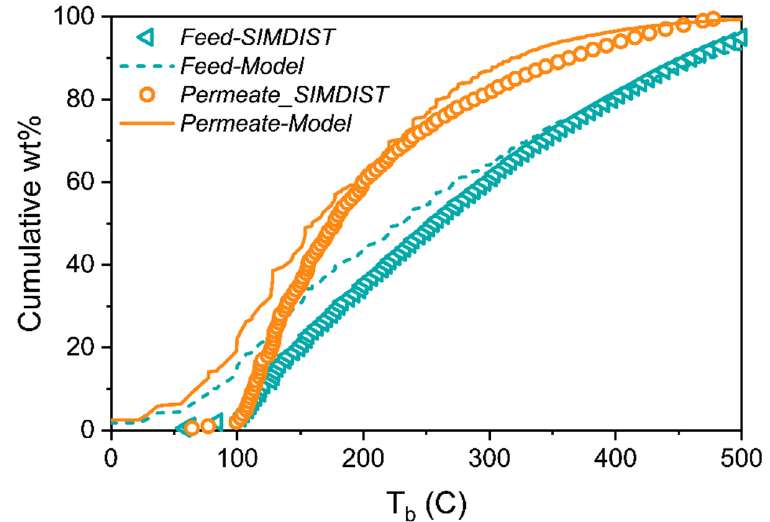
Figure 7. Comparison of the feed SIMDIST [3] to model of composition for a light shale crude oil,